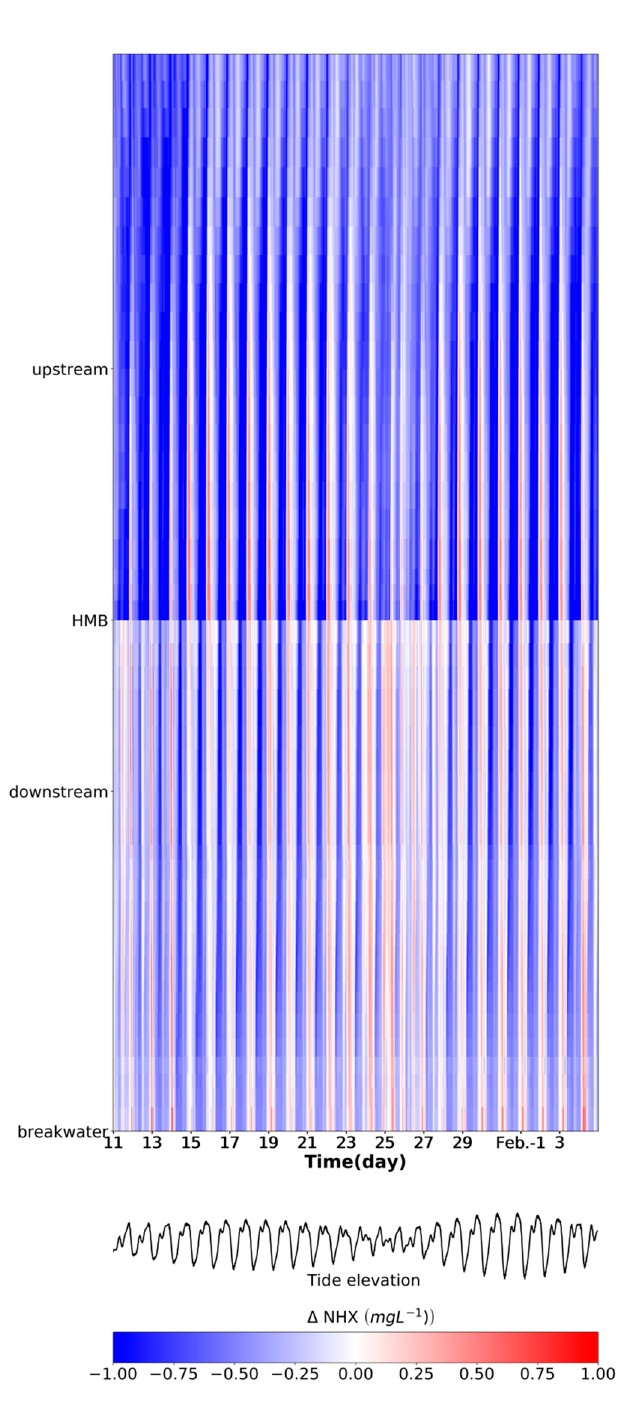
Figure 6. Hovmöller diagram of the di ff erence (tide-receiving scenario minus non-tide-receiving scenario) in the concentration of ammonia along the river. The x -axis represents the time evolution and the y -axis depicts the location along the river. The tide elevation is plotted in the lower panel to identify tidal phases.